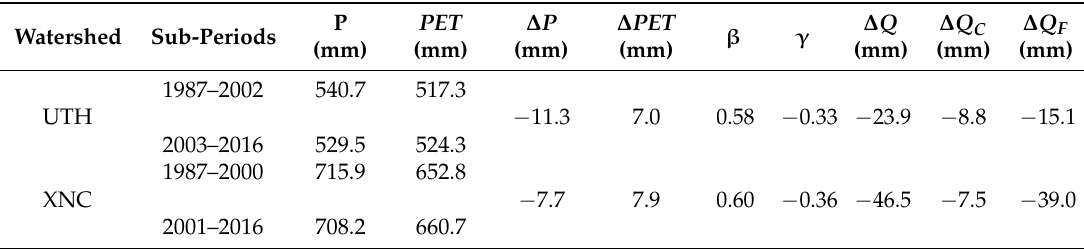
Table 5. The relative contributions of climate variability and forest recovery calculated by the sensitivity-based